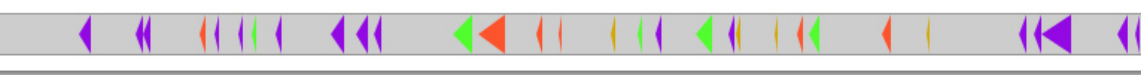
Figure 5. Different kinds of moves visually illustrated as glyphs with variable widths. We use the term move with respect to a soccer game to describe an interval of arbitrary length, starting with the seizure of the ball and ending with a final turnover. The color of a move represents its most characteristic semantically-meaningful feature (for the meaning of the color, see Table 1). The width of a glyph illustrates the duration of the respective move. The shape of an isosceles triangle is used to indicate the development of a game move over time with its moment of escalation (e.g., shot on